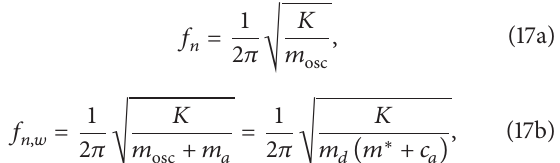
Figure 10: Variations of the amplitude ratios and the frequency ratios against the reduced velocities for diamond prism. Amplitude ratio 𝐴 ∗ = 𝐴/𝐷 ; frequency ratio 𝑓 ∗ = 𝑓 the natural frequency. (a-1) The responses of amplitude ratios, 𝑚 ∗ = 2.2 ; (a-2) the responses of frequency ratios, 𝑚 ∗ = 2.2 ; (b-1) the responses of amplitude ratios, 𝑚 ∗ = 4.2 ; (b-2) the responses of frequency ratios, 𝑚 ∗ = 4.2